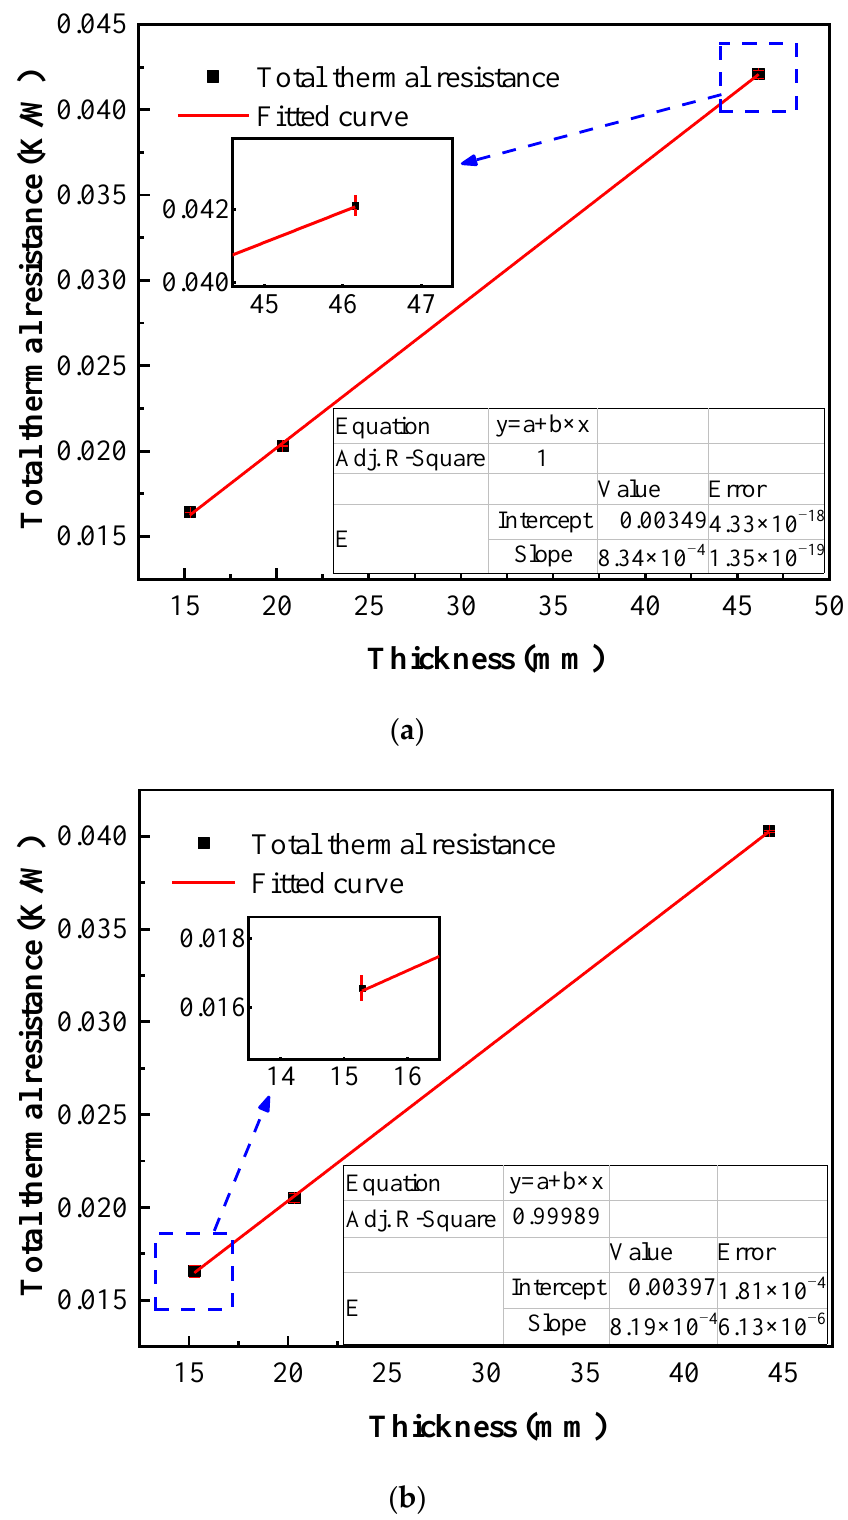
Figure 8. The total thermal resistances of SEP10 with different thickness. ( a ) Qualitative temperature of 12.5 °C and ( b ) qualitative temperature of 27 °C .